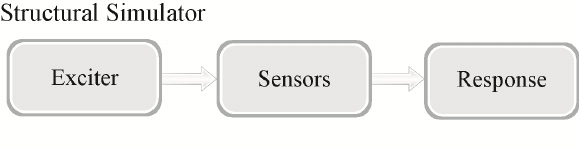
Fig. 1. Structural